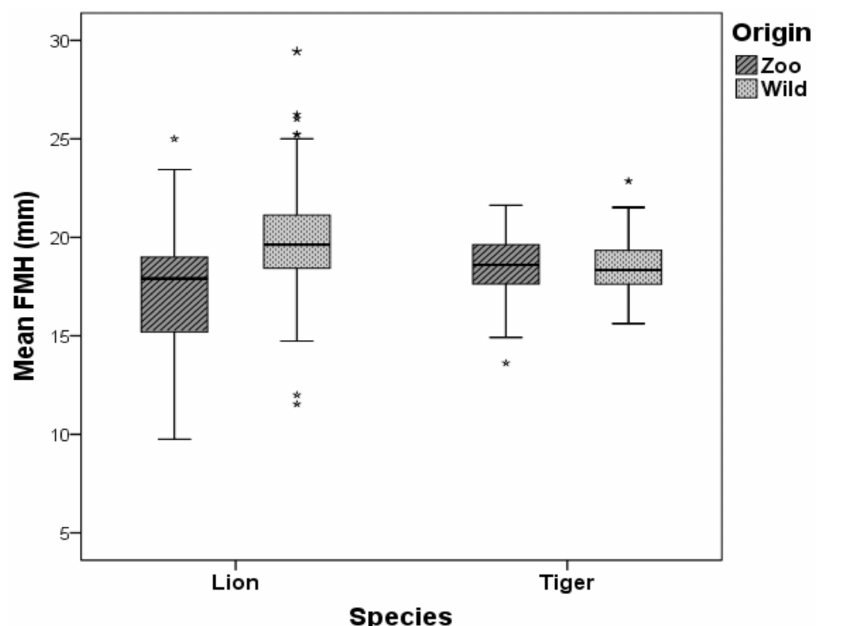
Figure 3. The mean foramen magnum height (FMH) in captive lions is significantly lower than that of lion skulls from wild populations (17.36 ± 3.20 and 19.77 ± 2.11 respectively; T -test: t=5.543, DF =61.969, P , 0.001). No statistically significant difference was noted between the captive and wild tiger populations. Asterisks represent outliers.